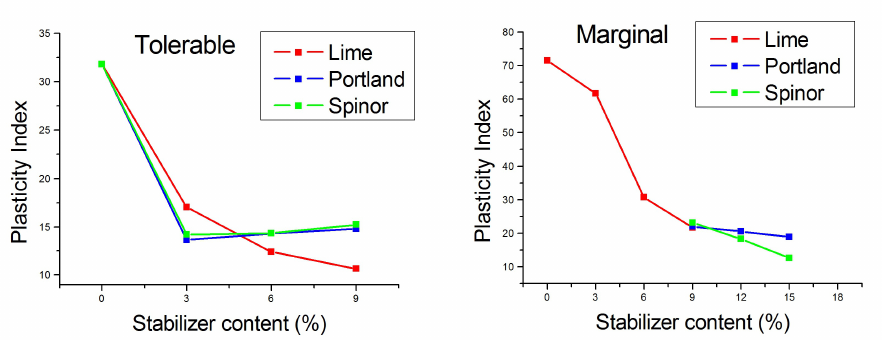
Figure 2. Plasticity index of stabilized soils with different fillers.